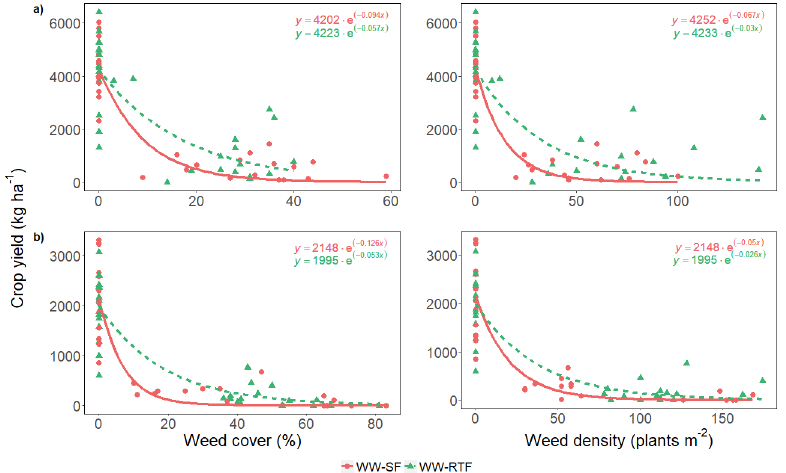
Fig 3. Relationship between crop yield (kg ha -1 ) and weed density (plants m -2 ) and weed cover (%) in 2017 (a) and 2018